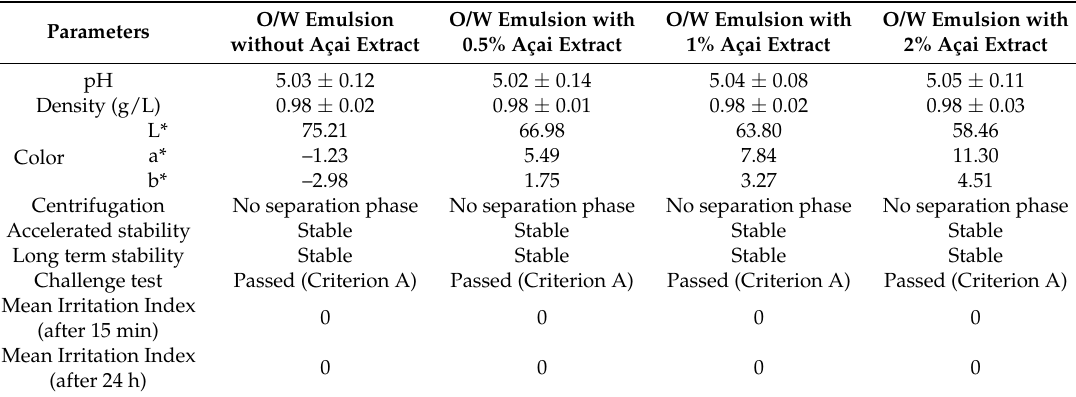
Table 2. General properties of açai formulations.